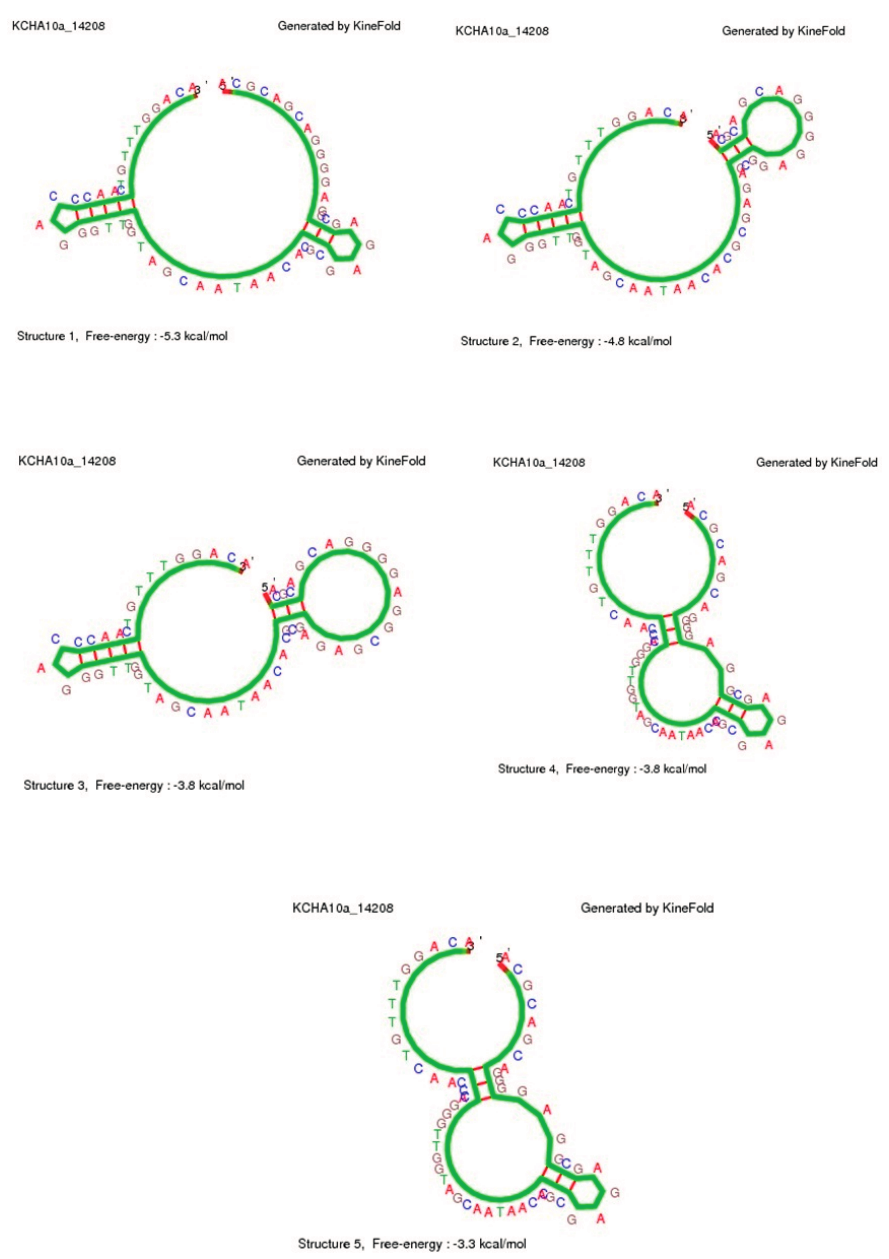
Figure 3. Simulation Results. Five predicated secondary structures of KCHA10a truncated